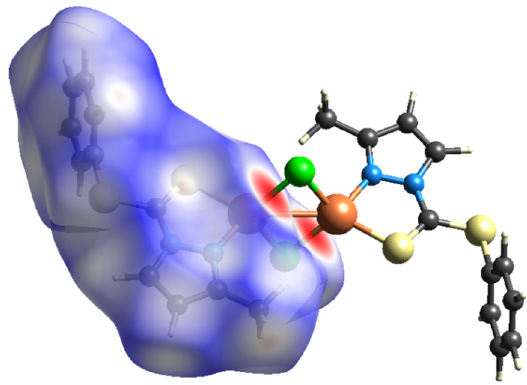
Figure 6. Visualization of the three-dimensional Hirshfeld surface of 2 mapped over norm in the range − 0.5221 to 1.1503. Color scheme: Cu = orange; Cl: green; S = yellow; and N = blue.